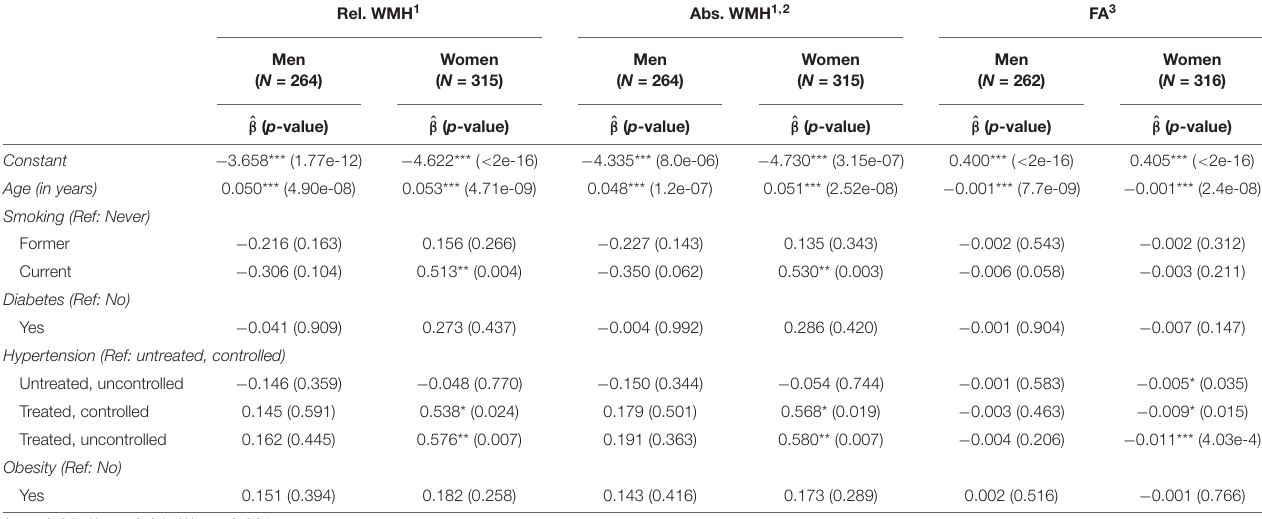
TABLE 4 | Associations of risk factors with MRI markers. Results from sex-stratified analysis.